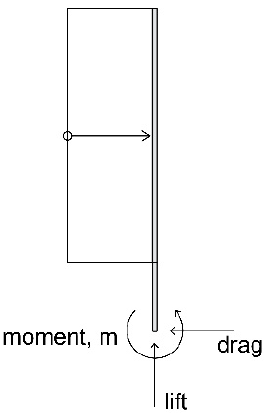
Figure 16. Free-body diagram of the frame for the tested models.